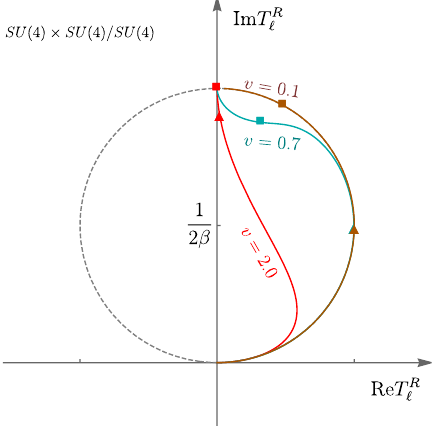
Figure 3 . Trajectories of the improved partial-wave amplitude on the complex plane of the am- plitude for the elastic scattering as m π /f π increased. The gray-dashed line corresponds to the unitarity circle (without the inelastic scattering), whose center is at (0 , 1 / 2 β ) and radius is 1 / 2 β . We assume SU( N f ) × SU( N f ) / SU( N f ) with N f = 4 and N c = 4 , and the adjoint representation for R . Each line corresponds to fixed v : v = 0 . 1 (brown), v = 0 . 7 (cyan), and v = 2 . 0 (red). There √ are two markers on each line, which correspond to m π /f π = 4 π/ N c and 4 π